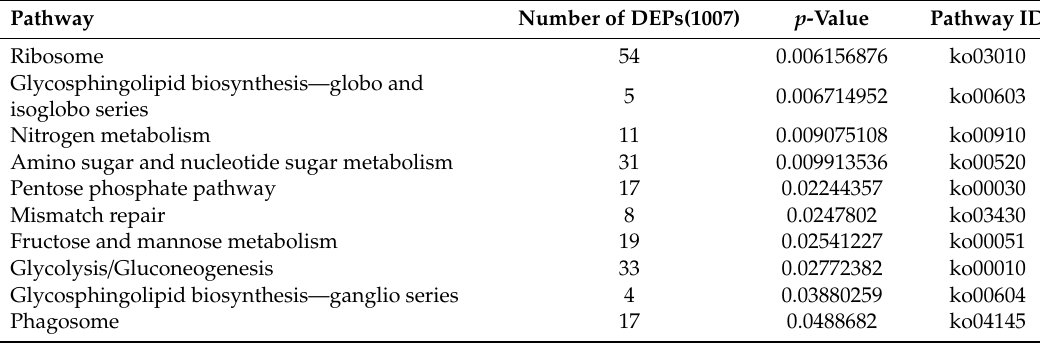
Table 1. Significant enrichment analysis of DEP Pathways in CD vs. CCK ( p < 0.05).